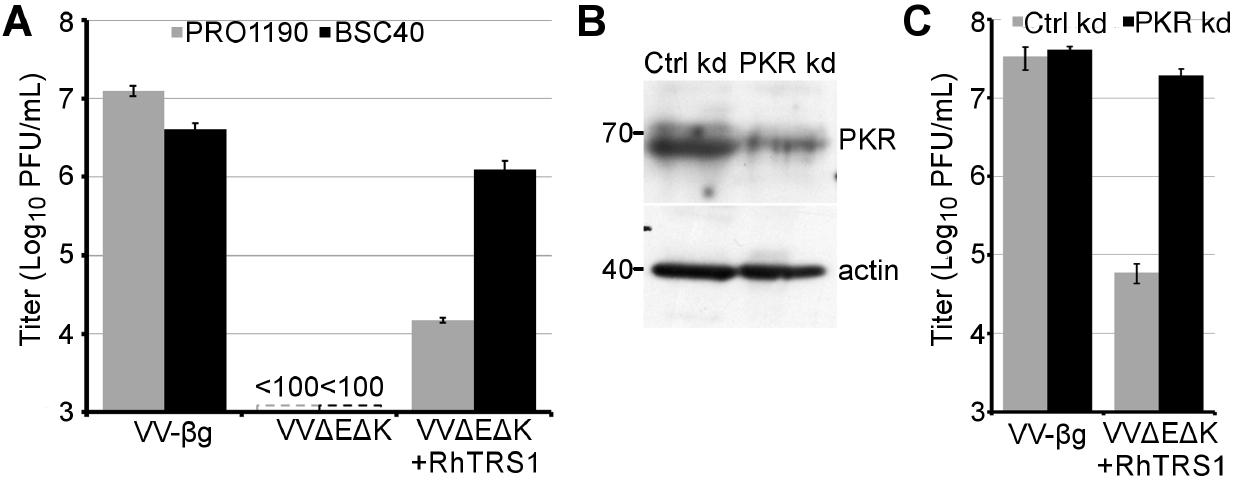
Figure 1. PKR inhibits VV D E D K + RhTRS1 replication in PRO1190 cells. (A) Titers of the indicated viruses produced 48 hpi (MOI=0.1) of PRO1190 (gray bars) or BSC40 cells (black bars), measured using HFF + TRS1. (B) Immunoblot of lysates of PRO1190 stably transduced with lentiviral vectors expressing control (left) or PKR-specific (right) shRNAs, probed with anti-PKR or anti-actin antibodies. (C) Titers of the indicated viruses 48 hpi (MOI=0.1) in either PRO1190 + ctrl shRNA (grey bars) or PRO1190 + PKR shRNA (black bars), measured using BSC40 cells. Results are represented as means + 1 STD.